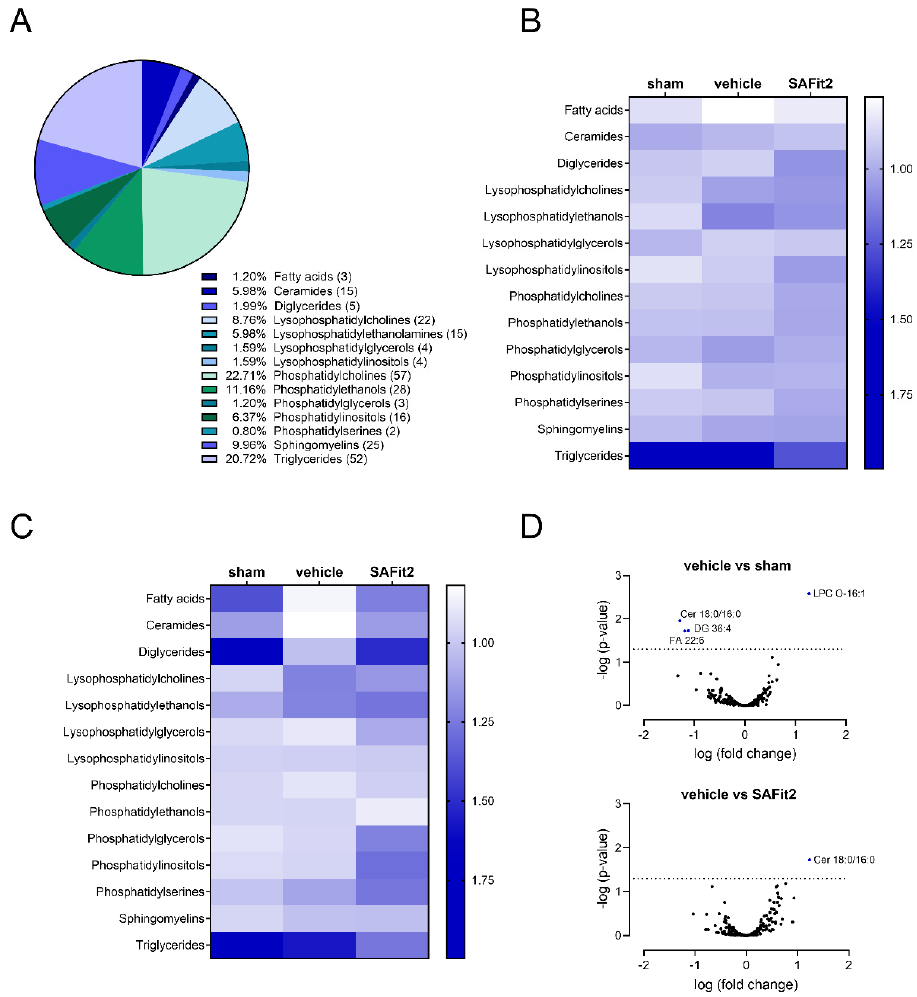
Figure 3. LC − HRMS lipid analysis of lumbar DRGs (L4 − L6) and the respective segments of spinal cord from nerve-injured mice after additional SAFit2 treatment. ( A ) Distribution of the number of measured analytes per lipid class in LC-HRMS analysis. ( B ) Abundancy of lipid classes in the spinal cord of the vehicle and 10 mg/kg SAFit2 treated SNI animals as well as sham animals. ( C ) Lipid levels of the lipid classes in lumbar DRGs of the vehicle and 10 mg/kg SAFit2-treated animals after SNI, and the sham animals. ( D ) Volcano plots comparing the lipid levels of the sham and vehicle-treated SNI animals (top) and vehicle and SAFit2-treated animals after SNI (bottom). A p -value of 0.05 was determined as a threshold for significance, which was calculated with a two-way ANOVA with a Tukey’s post-hoc test. All significantly altered lipids were labeled and depicted in blue. Abbreviations: DRGs: dorsal root ganglia; LC − HRMS: liquid chromatography–high-resolution mass spectrometry; SAFit2: selective antagonist of FKBP51 by induced fit 2; SNI: spared nerve injury. For investigating the effect of SAFit2 on individual lipids, we plotted the logarithmic